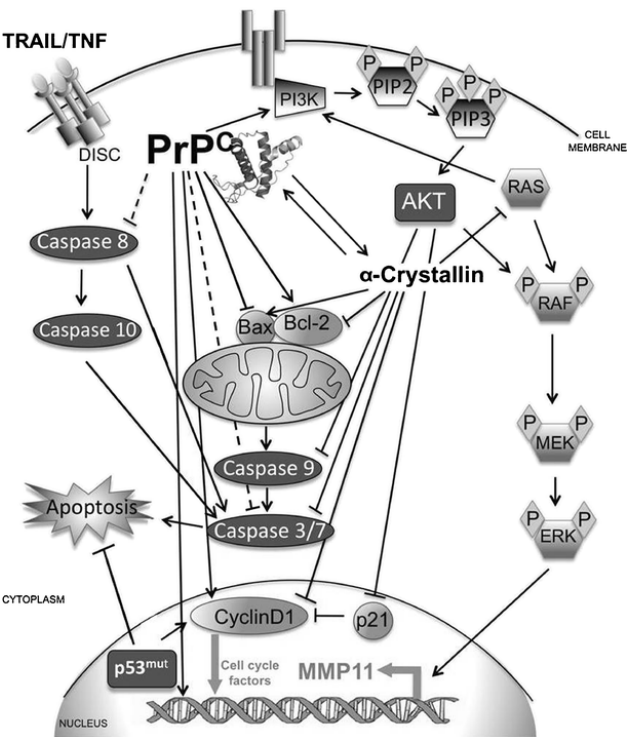
Figure 1. Schematic diagram showing the molecular interactions of the cellular prion protein (PrP C ). Reprinted from Ref. [7] with permission from Springer Nature. License Number: 5383991150266.